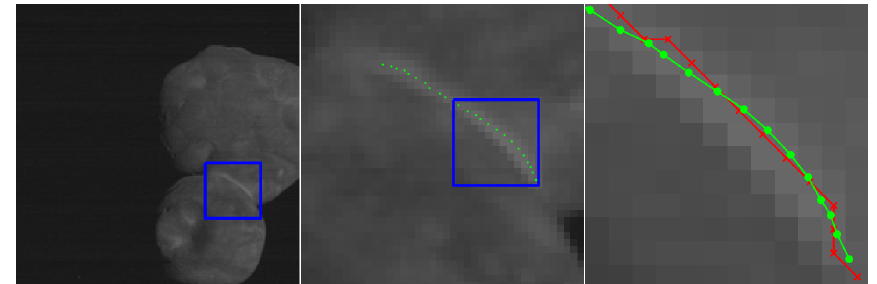
Figure 15. Image of Kuiper belt object Arrokoth (formerly called Ultima Thule) collected by the New Horizon spacecraft’s Long Range Reconnaissance Imager (LORRI) during a flyby in early 2019 (credit for raw image: NASA/Johns Hopkins University Applied Physics Laboratory/Southwest Research Institute). The red symbols denote pixel-level streak estimates and green dots denote the refined × subpixel localization estimates.